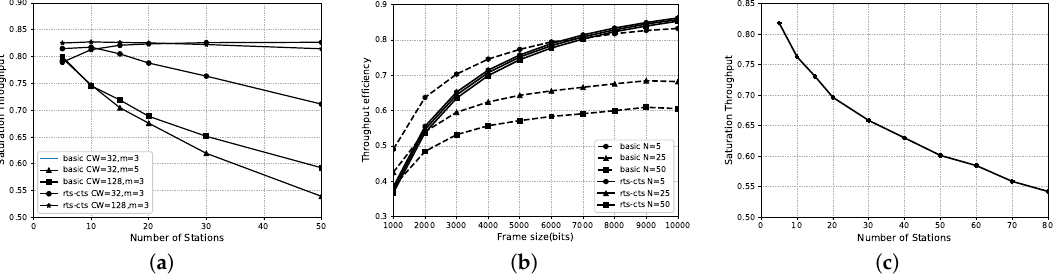
Figure 2. Comparison of simulation results with past works. ( a ) Comparison with Bianchi’s work; ( b ) Comparison with Chatzimisios’s work; ( c ) Comparison with Wu’s work.